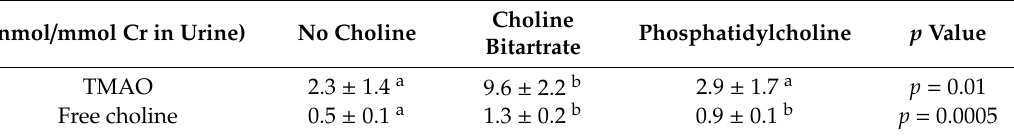
Table 3. E ff ects of the study meals on urinary concentrations of trimethylamine- N -oxide (TMAO) and choline adjusted for creatinine (Cr) change from 0 min study-baseline. One-way ANOVA, Tukey-Kramer post hoc test showed a significant e ff ect of study meal for TMAO and choline change from baseline as indicated by di ff erent letter superscripts. Values are mean ± SEM, n = 37 per study meal. (nmol / mmol Cr in Urine) No